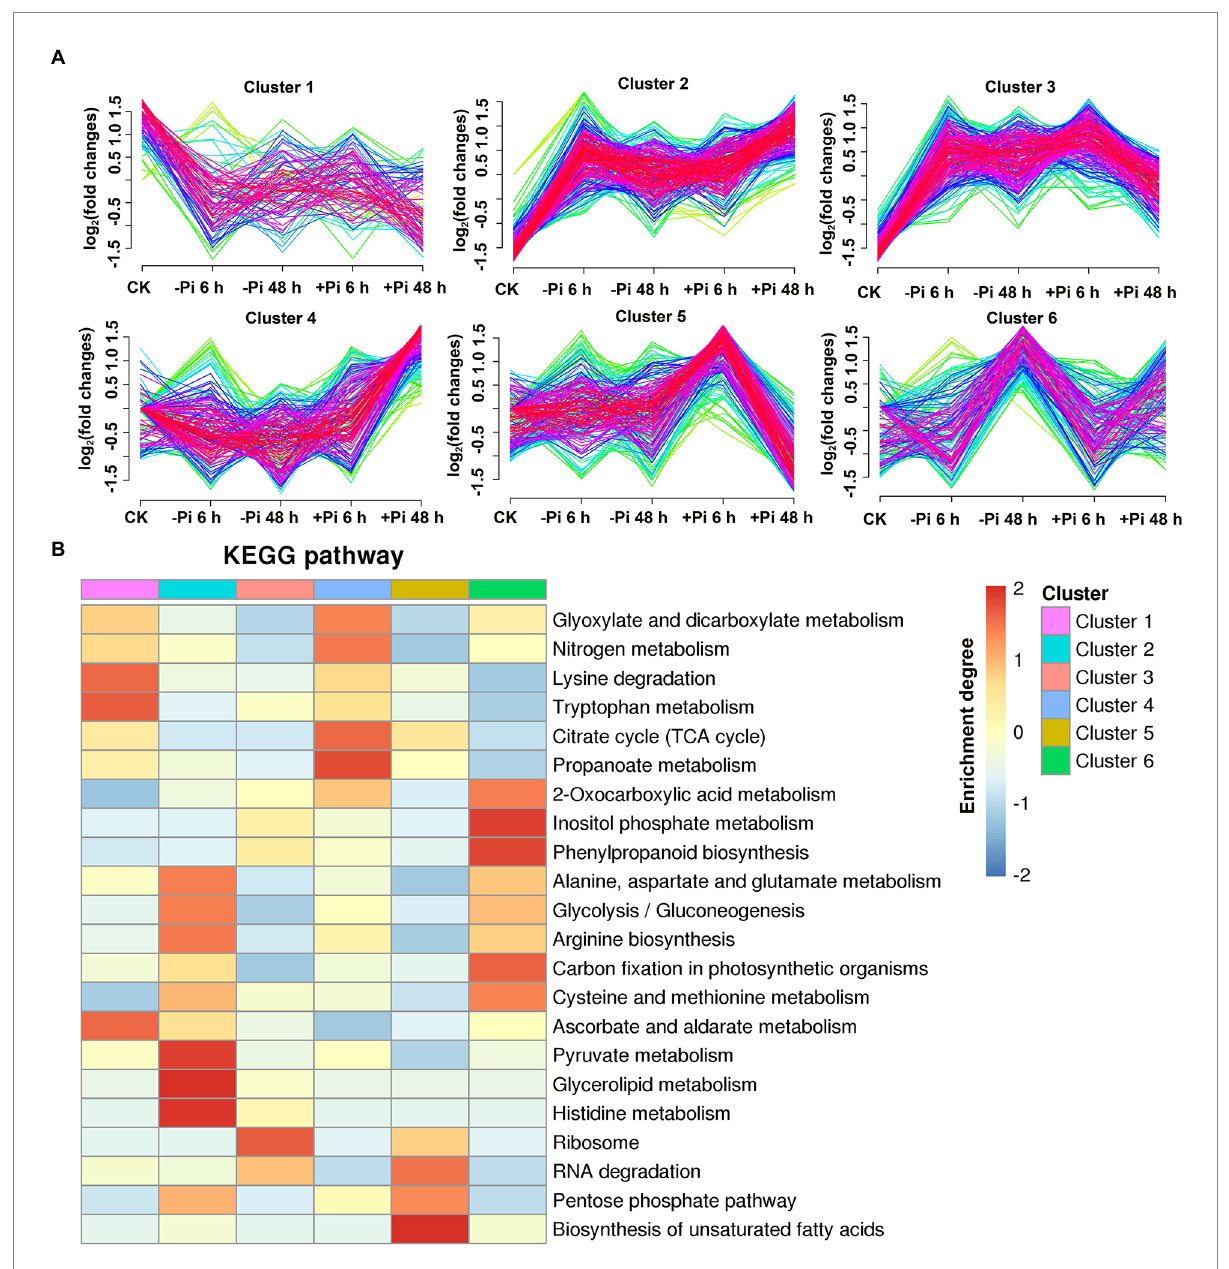
FIGURE 6 Clustering analysis of succinylated proteins based on their expression pattern in response to Pi recovery using a Mfuzz package (A) and KEGG pathways that are overrepresented in each cluster based on the succinylation intensity relative to the control (B) . –Pi, Pi starvation; +Pi, Pi recovery. The colored scale bar shows the enrichment degree of pathways to perform z -score processing on-log (Fisher’s exact test p value). KEGG, Kyoto Encyclopedia of Genes and Genomes; Pi, intracellular